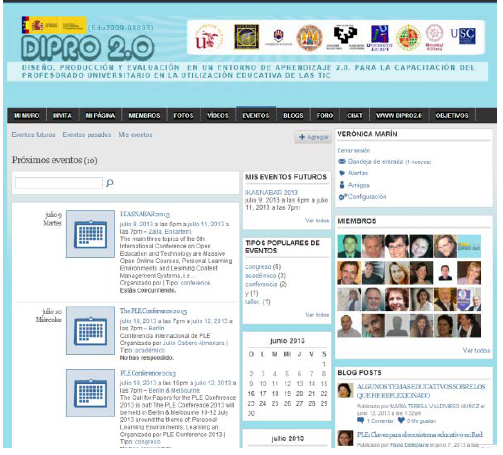
Figure 2 . DIPRO 2.0 events.